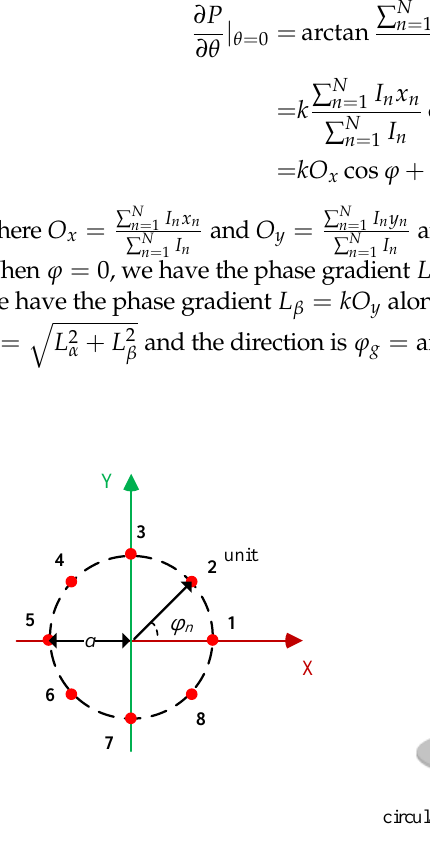
Figure 3. Circular array